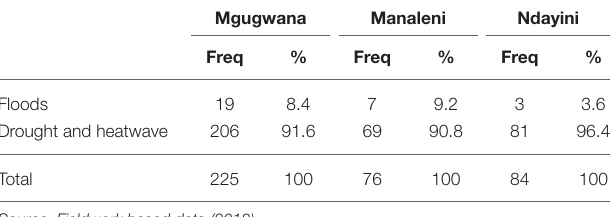
TABLE 2 | Type of climate change affecting the rural households.